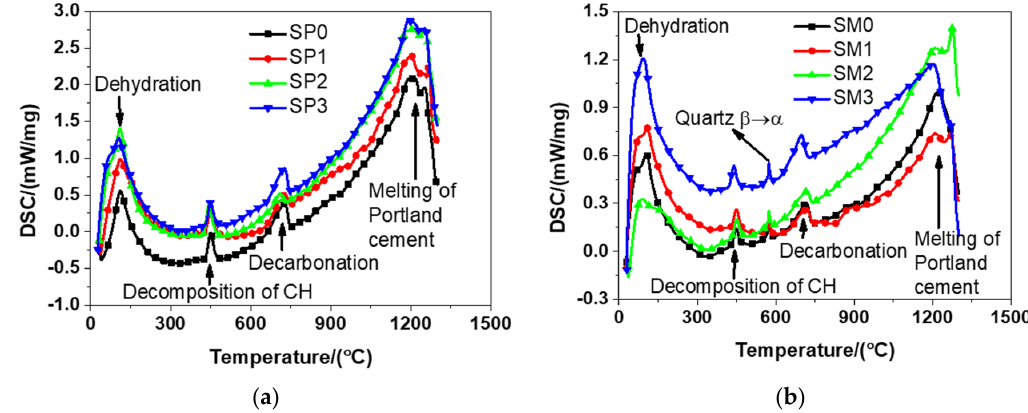
Figure 12. The differential scanning calorimetry results of siliceous sacrificial cement paste and mortar: ( a ) siliceous sacrificial cement paste; ( b ) siliceous sacrificial mortar.